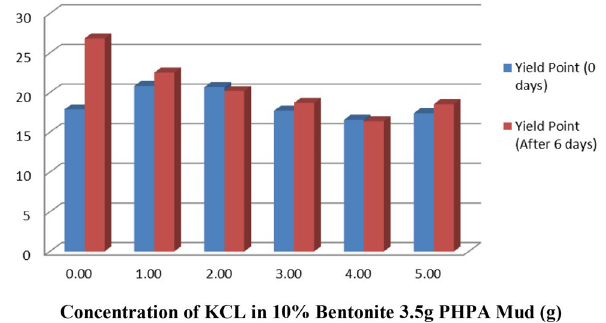
Fig. 18 Effect of NaCl, KCl and haematite on gel strength (after 10 min) of PHPA–bentonite mud